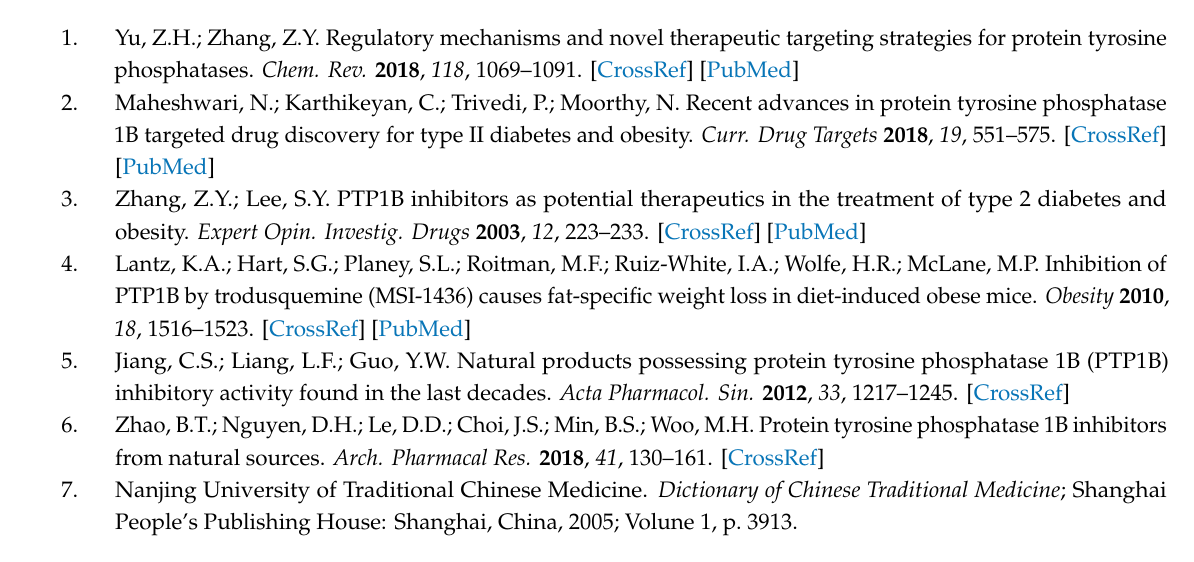
Supplementary Materials: The following are available online. NMR, IR HRESIMS, ECD and UV spectroscopic data of isolated compounds ( 1 and 2